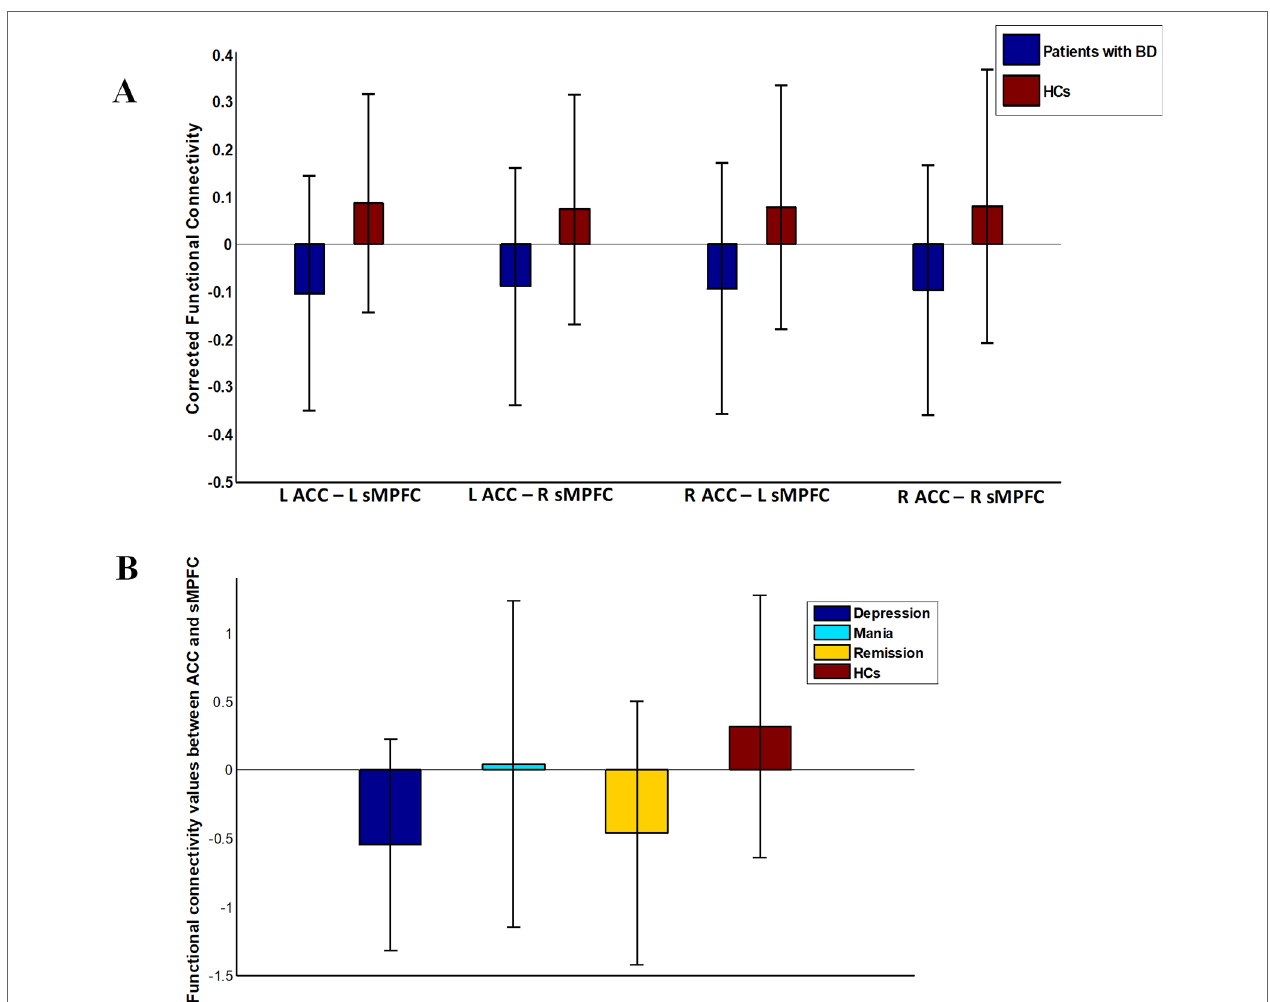
FIgURE 2 | Functional connectivity in patients with bipolar disorder (BD) versus healthy controls (HCs). Error bars stand for ±1 standard deviation. (A) Patients with BD showed four significantly reduced functional connections between ACC and sMPFC (FDR corrected with p < 0.05); (B) There was an omnibus difference in the summation value of the aforementioned four abnormal functional connections across all diagnostic